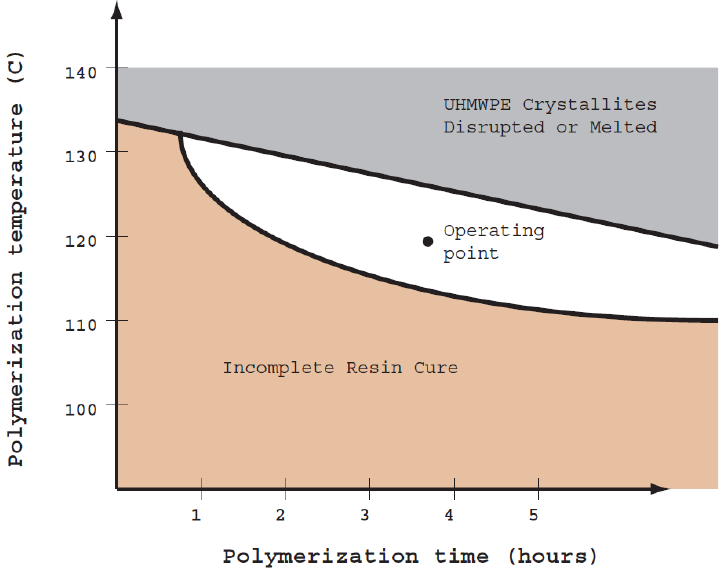
Figure 4. Graphical representation of the composite processing window for the vacuum bagging process.